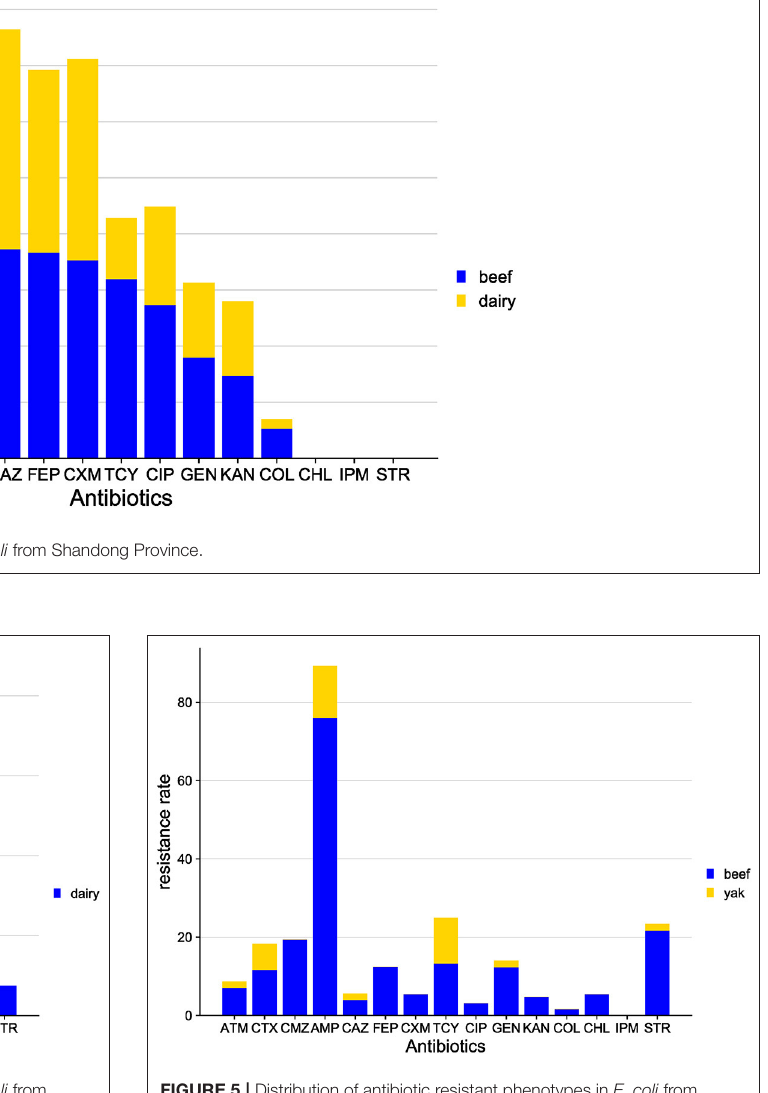
The MIC results of 48 selected multidrug-resistant E.